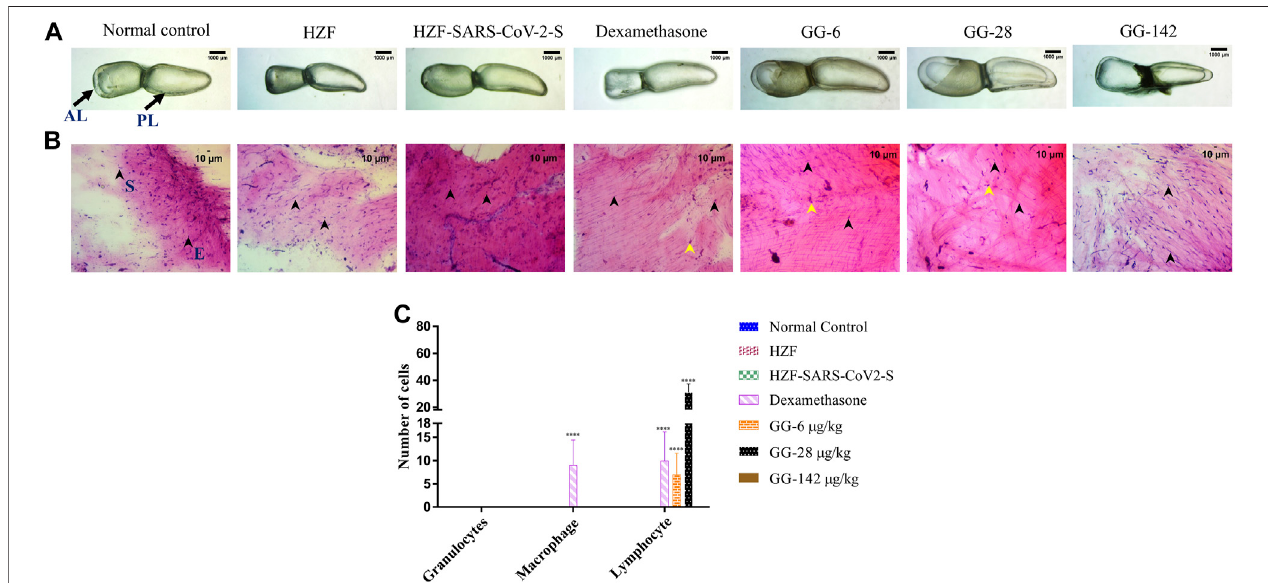
FIGURE 4 | Comparison of changes in swim bladder morphology, cytology, and immune cell in fi ltrates at 7-days time point. (A) Morphological changes in swim bladder with SARS-CoV-2 spike-protein induction, and treatment with Dexamethasone and Giloy Ghanvati (GG) at different concentrations (6, 28, and 142 μ g/kg/day) comparedtothenormalcontrolandhumanizedzebra fi sh. Imagesdepictlateralviewwiththeanteriorlobe(AL)and posteriorlobe(PL)marked. Imagesweretakenat × 1 magni fi cation. (B) . Hematoxylin-Eosin stained cytology smears of whole swim bladder captured using × 20 objective magni fi cation. Normal cell nuclei depicted by black arrowheads; E- Epithelial cells, and S- Smooth muscle cells. Yellow arrowheads in the images show lymphocytes. (C) Quantitative estimation of immune cell in fi ltrates in the swim bladder. Data points are depicted as mean ± S.D. analyzed by Two-Way ANOVA followed by Tukey ’ s multiple comparisons test. (****) p < 0.0001 compared to disease control, n (cid:2)